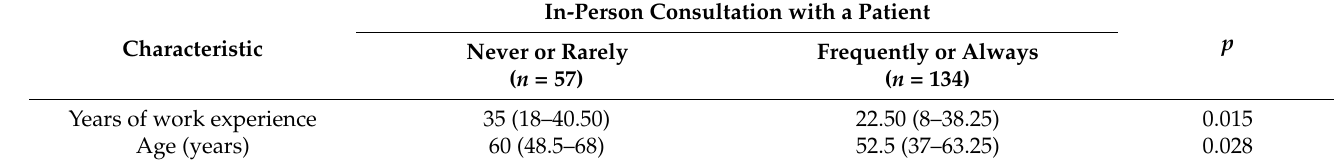
Table 6. Relationships between the sociodemographic characteristics of the respondents and the in-person toolof